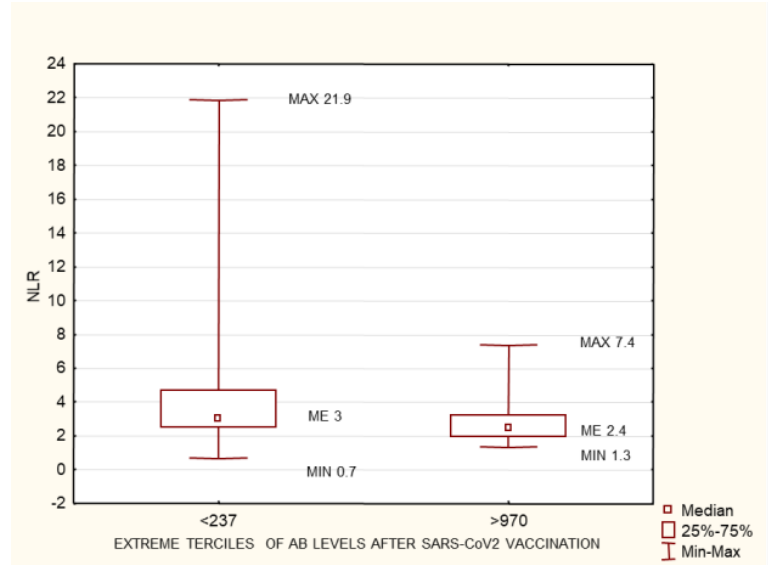
Figure 10. The group of patients with no history of SARS-CoV-2 infection prior to vaccination. Statistically significant differences in the neutrophil-to-lymphocyte ratio between the extreme terciles of post-SARS-CoV-2 vaccination antibody levels <237 AU/mL and >970 AU/mL. Mann–Whitney U test. p = 0.03. AB: antibody, NLR: neutrophil-to-lymphocyte test. p = 0.03. AB: antibody, NLR: neutrophil-to-lymphocyte ratio.